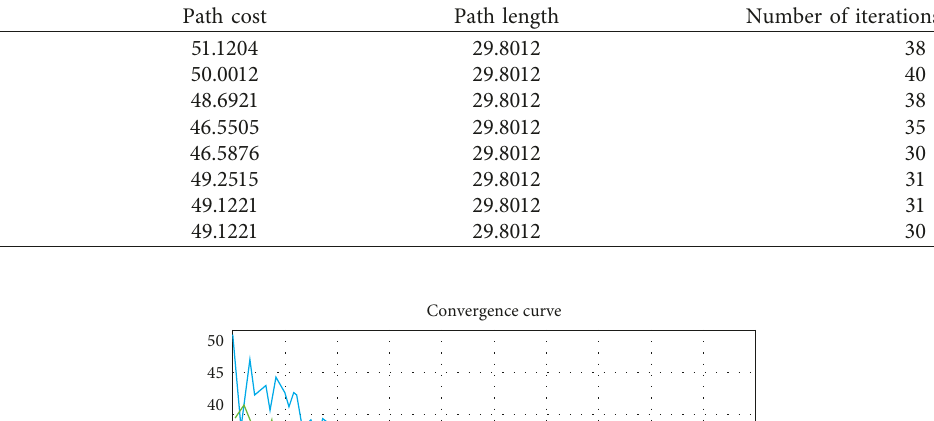
Table 2: Influence of the number of ants m on the performance of the algorithm.